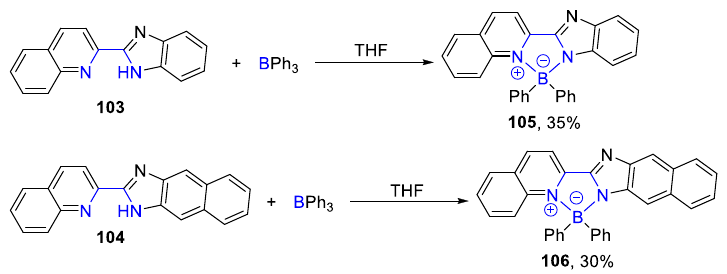
Scheme 19. Reactions of 2-(5-methyl-1 H -pyrrol-2-yl)pyridine, 2-(5-methyl-1 H